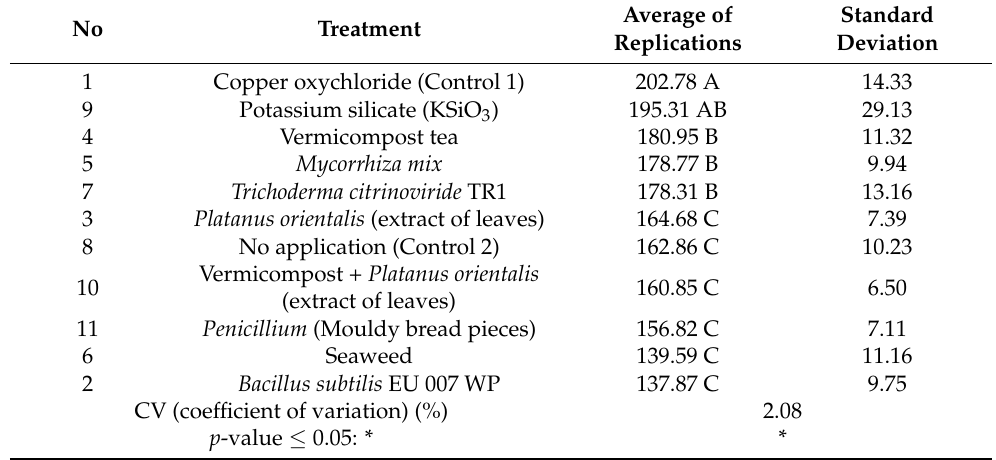
Table 5. TWSP (mgCAE.100g − 1 olive fruit) content in the trial. Letters indicate significant